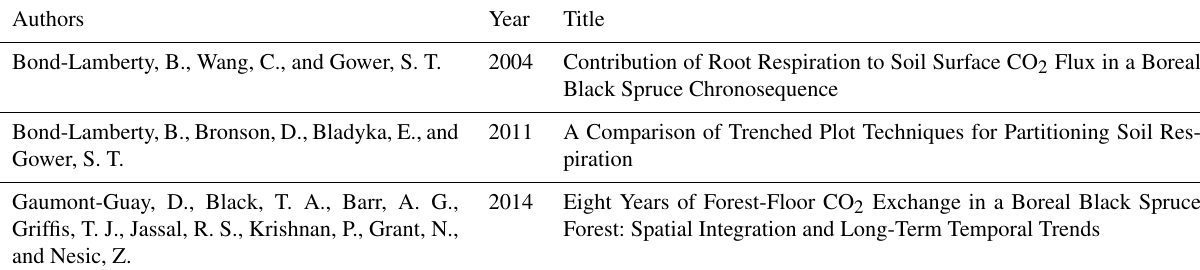
Table A1. List of articles used to create Fig.